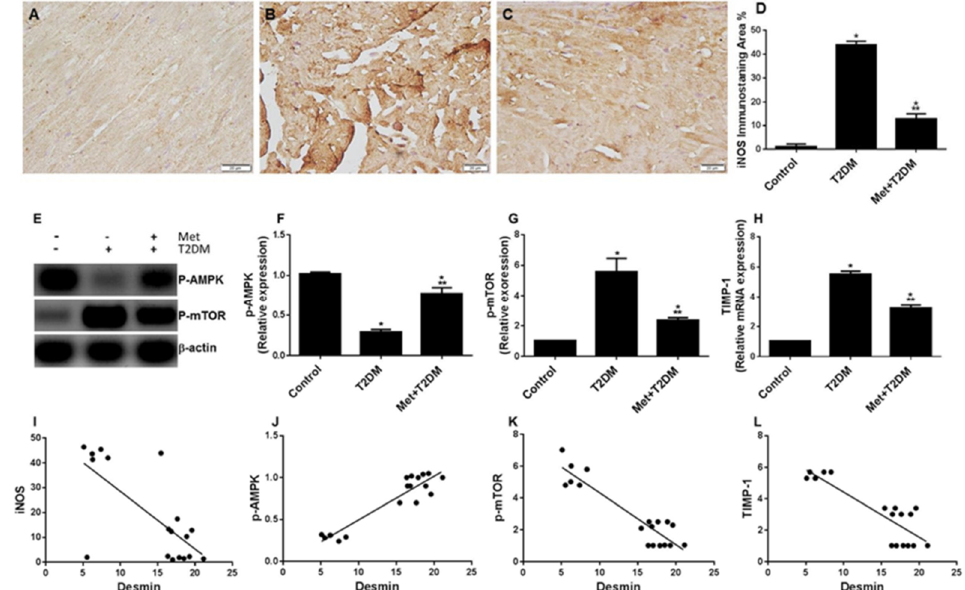
Figure 5. Metformin (Met) protects against the inhibition of cardiac desmin expression and ECG abnormalities caused by T2DM. iNOS immunohistochemistry of left ventricle sections (400×) obtained 10 weeks post diabetic induction from the untreated control ( A ), T2DM ( B ), and Met + T2DM ( C ) groups are depicted (Scale = 20 μ m). Histograms in ( D ) represent a quantitative analysis of desmin immunostaining area % in cardiac sections from the above groups. Cardiac lysates prepared from the above groups were immunoblotted with antibodies against p-AMPK, p-mTOR, and β -actin as a loading control ( E ). The relative expression of these signaling proteins is shown ( F , G ). Histograms in ( H ) display the relative mRNA expression of TIMP-1 in all animal groups. In E , −− , represent the Control group; − +, represent T2DM group; and ++, represent the treated group. The presented p values are all significant. * p < 0.01 versus control, ** p < 0.0001 versus T2DM. ( I – L ) Correlation between either the desmin score versus iNOS (I) and p-AMP ( J ) or the score of sarcomere damage versus p-mTOR ( K ) and TIMP-1 ( L ). iNOS: inducible nitric oxide synthase; T2DM: type 2 diabetes mellitus; AMPK: AMP-activated protein kinase; mTOR: mammalian target of ra- pamycin; TIMP-1: tissue inhibitor of metalloproteinase-1.